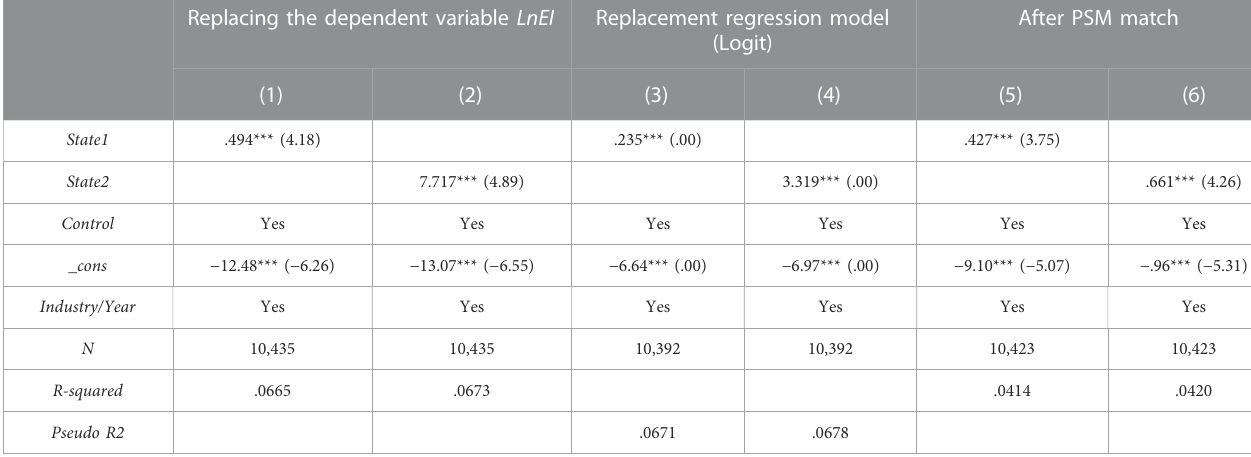
TABLE 7 Robustness test